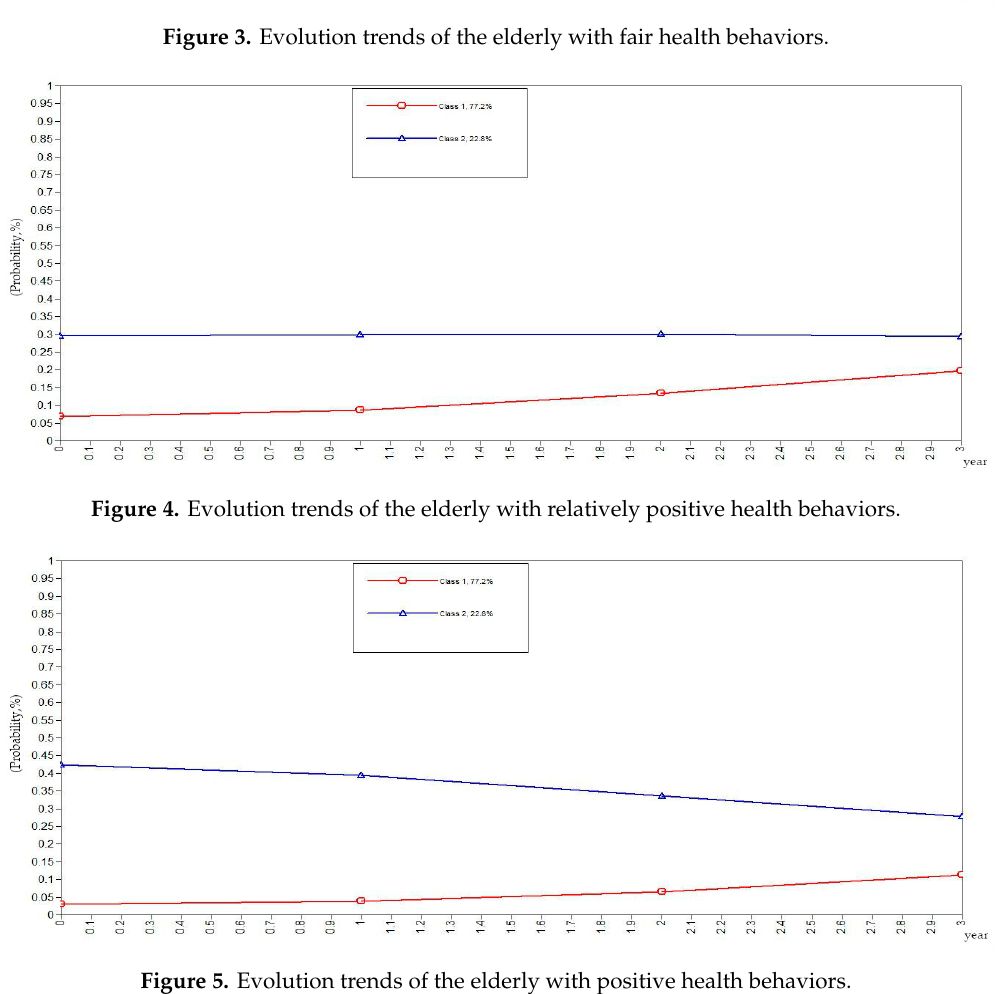
Figure 5. Evolution trends of the elderly with positive health behaviors.